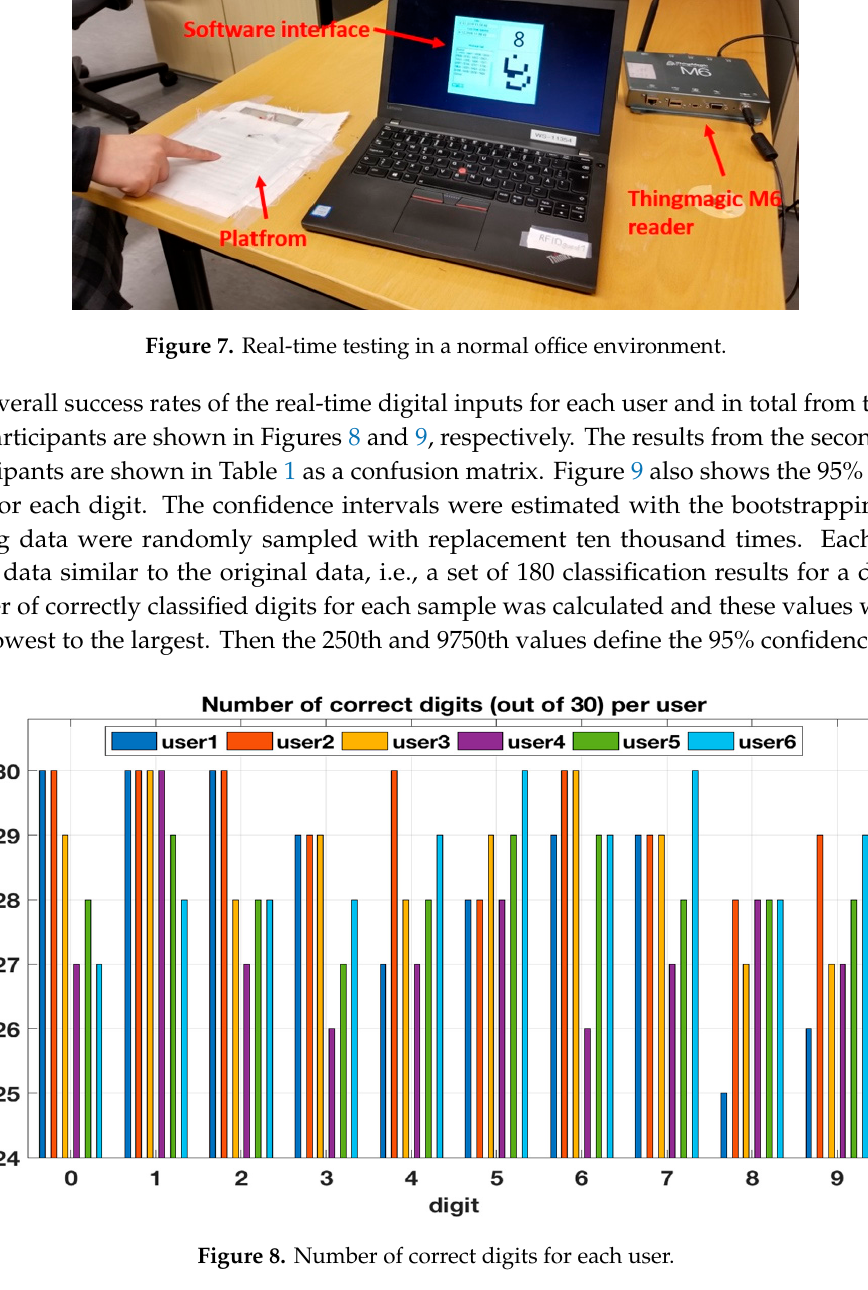
Figure 9. Number of correctly classified inputs for each digit with the confidence intervals for each digit. Table 1. Confusion matrix for real-time recognition testing with metrics (precision, recall, F1 score) for each digit.